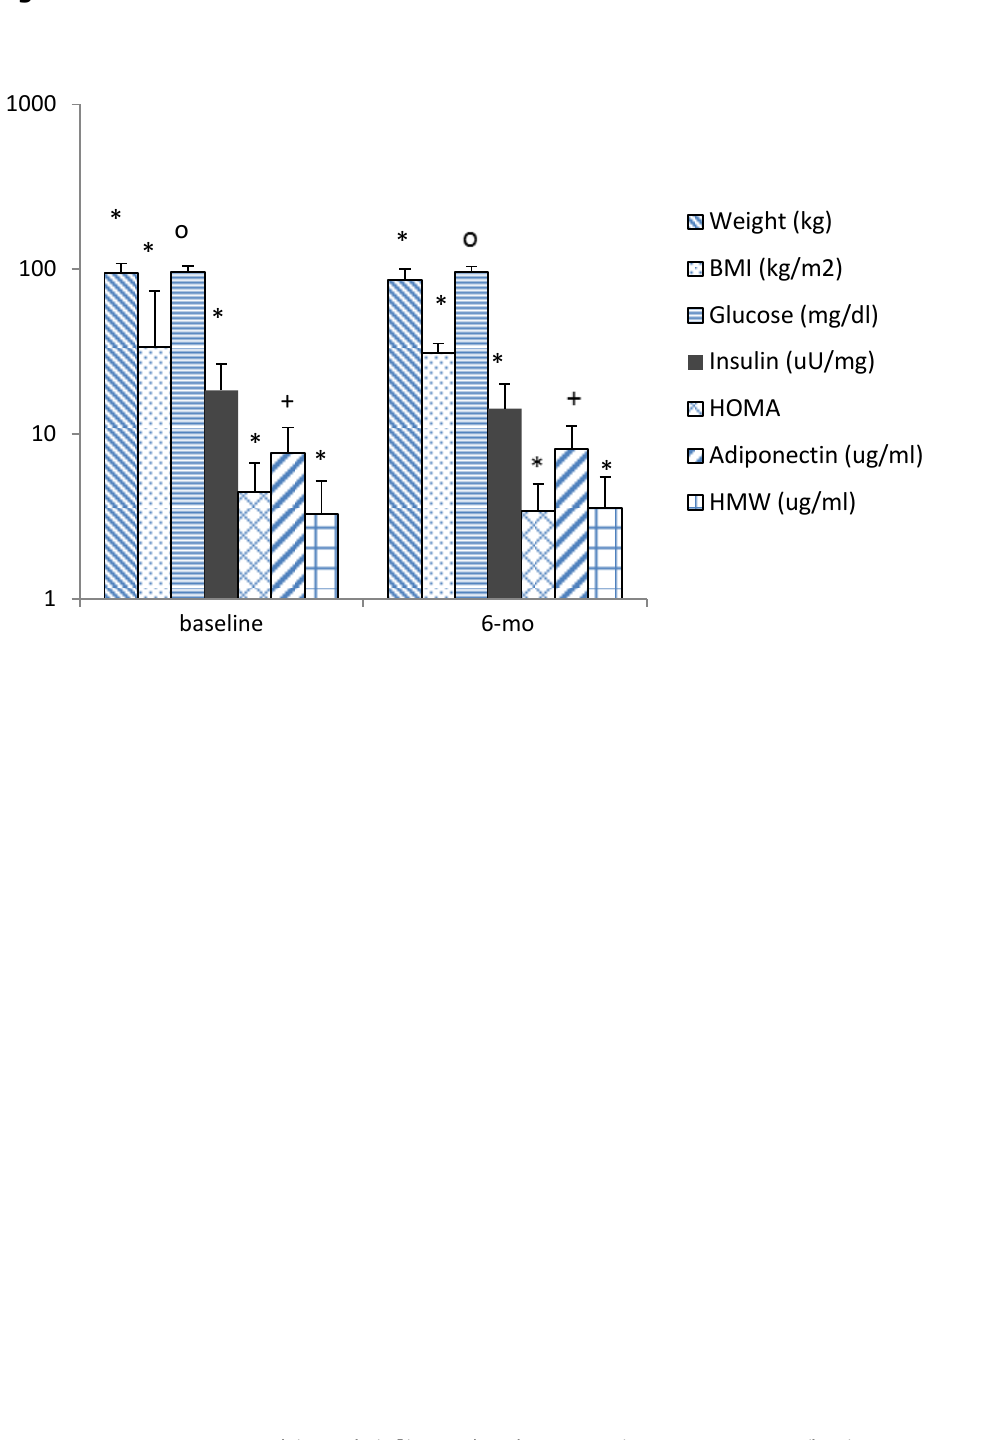
Figure 3. Measures at baseline and 6-month